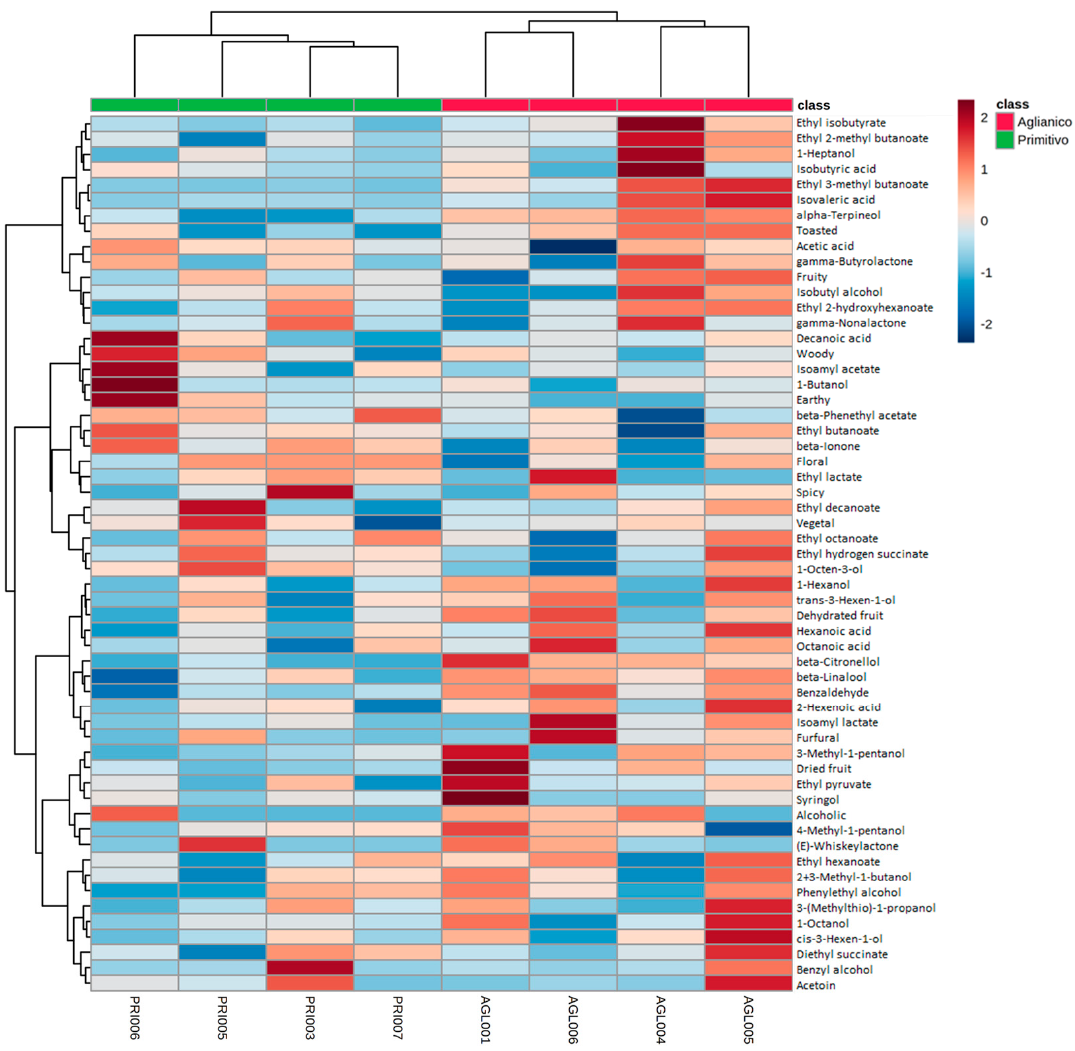
Figure 2. Heat map visualization of the wines (four Aglianico: AGL; four Primitivo: PRI) according to volatile composition and olfactory characteristics classified by a hierarchical cluster.